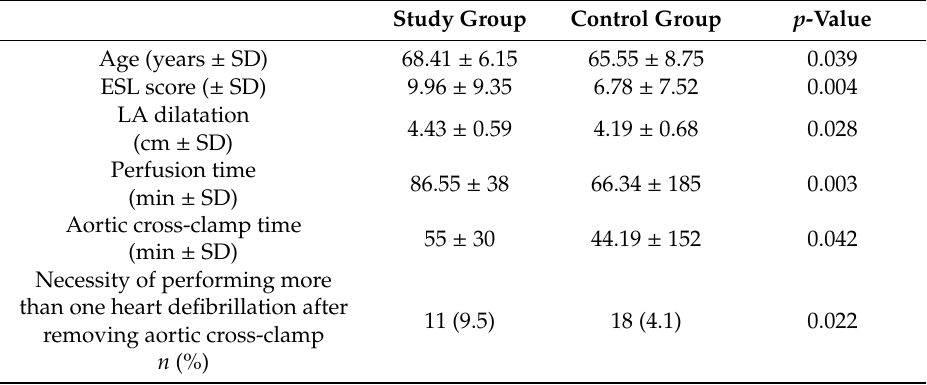
Table 8. Factors predisposing to the occurrence of postoperative